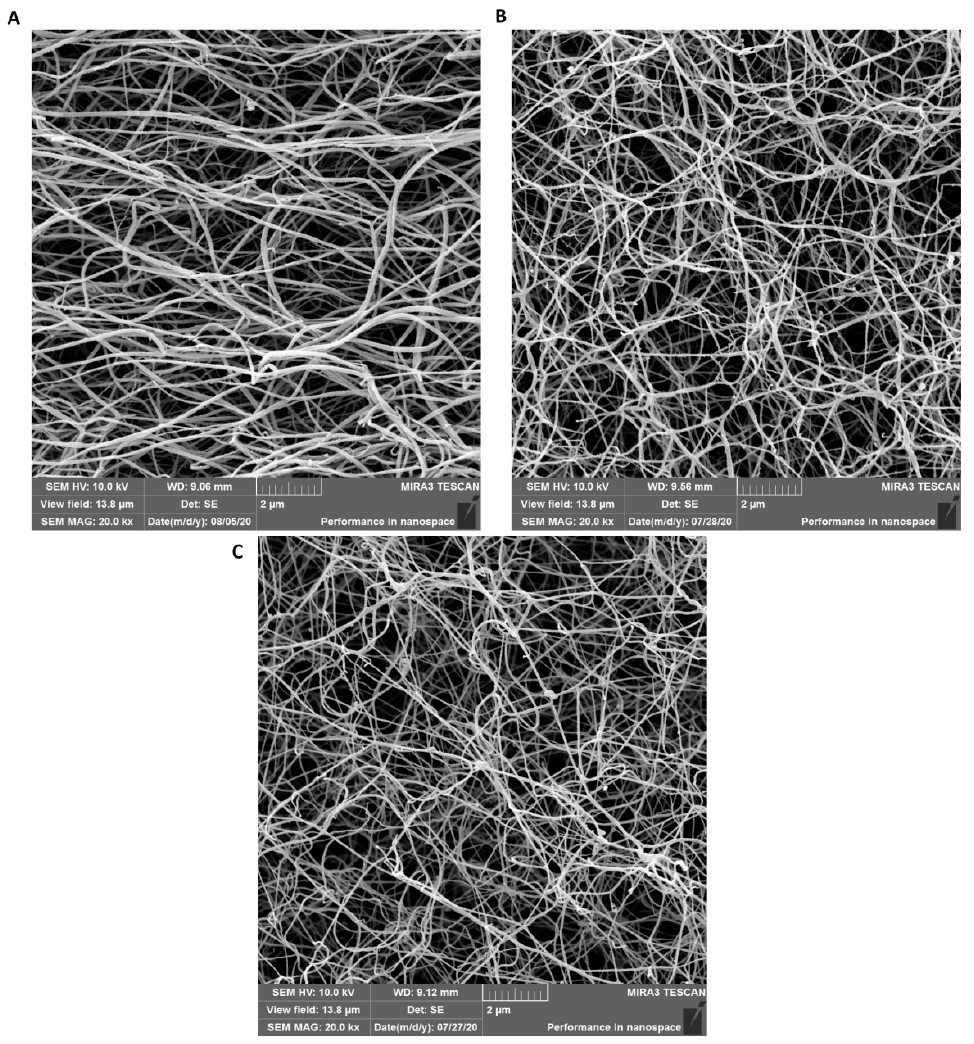
U/mL) ( B ) to the citrated plasma (patients (blue and red lines) or citrated control plasma (green line)). Fibrinolysis ( C ) in plasma patients (blue and red lines) or control plasma (green line). The fibrin clot of patient 1 had denser and thicker fibers (97.6 ± 51.8 nm) compared to the control (74.9 ± 27.4 nm). The fibrin clot structure of patient 2 was very similar to the control, even though their average fiber diameter was 80.6 ± 28.8 nm ( n = 500) ( p = 0.05) (Figure 3A–C).